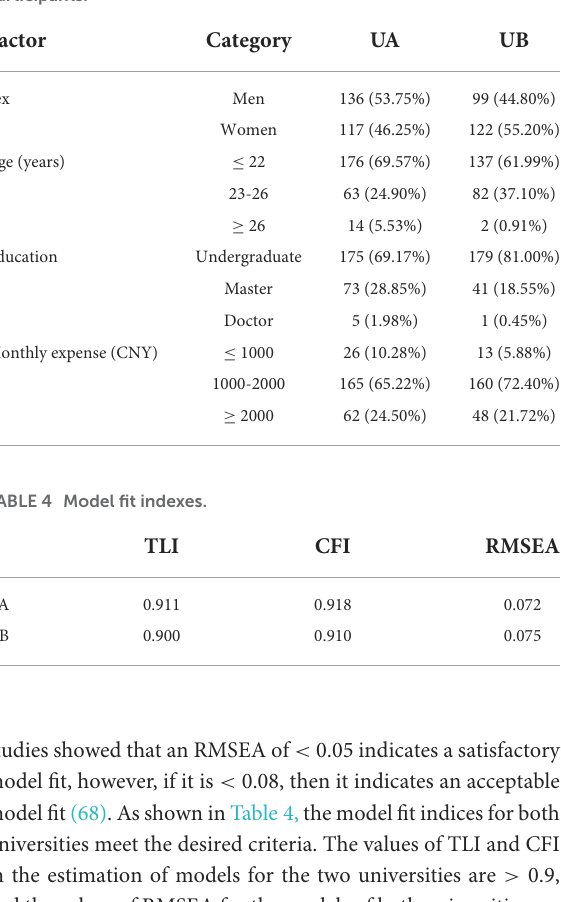
TABLE 3 Descriptive statistics on demographic characteristics of the participants.